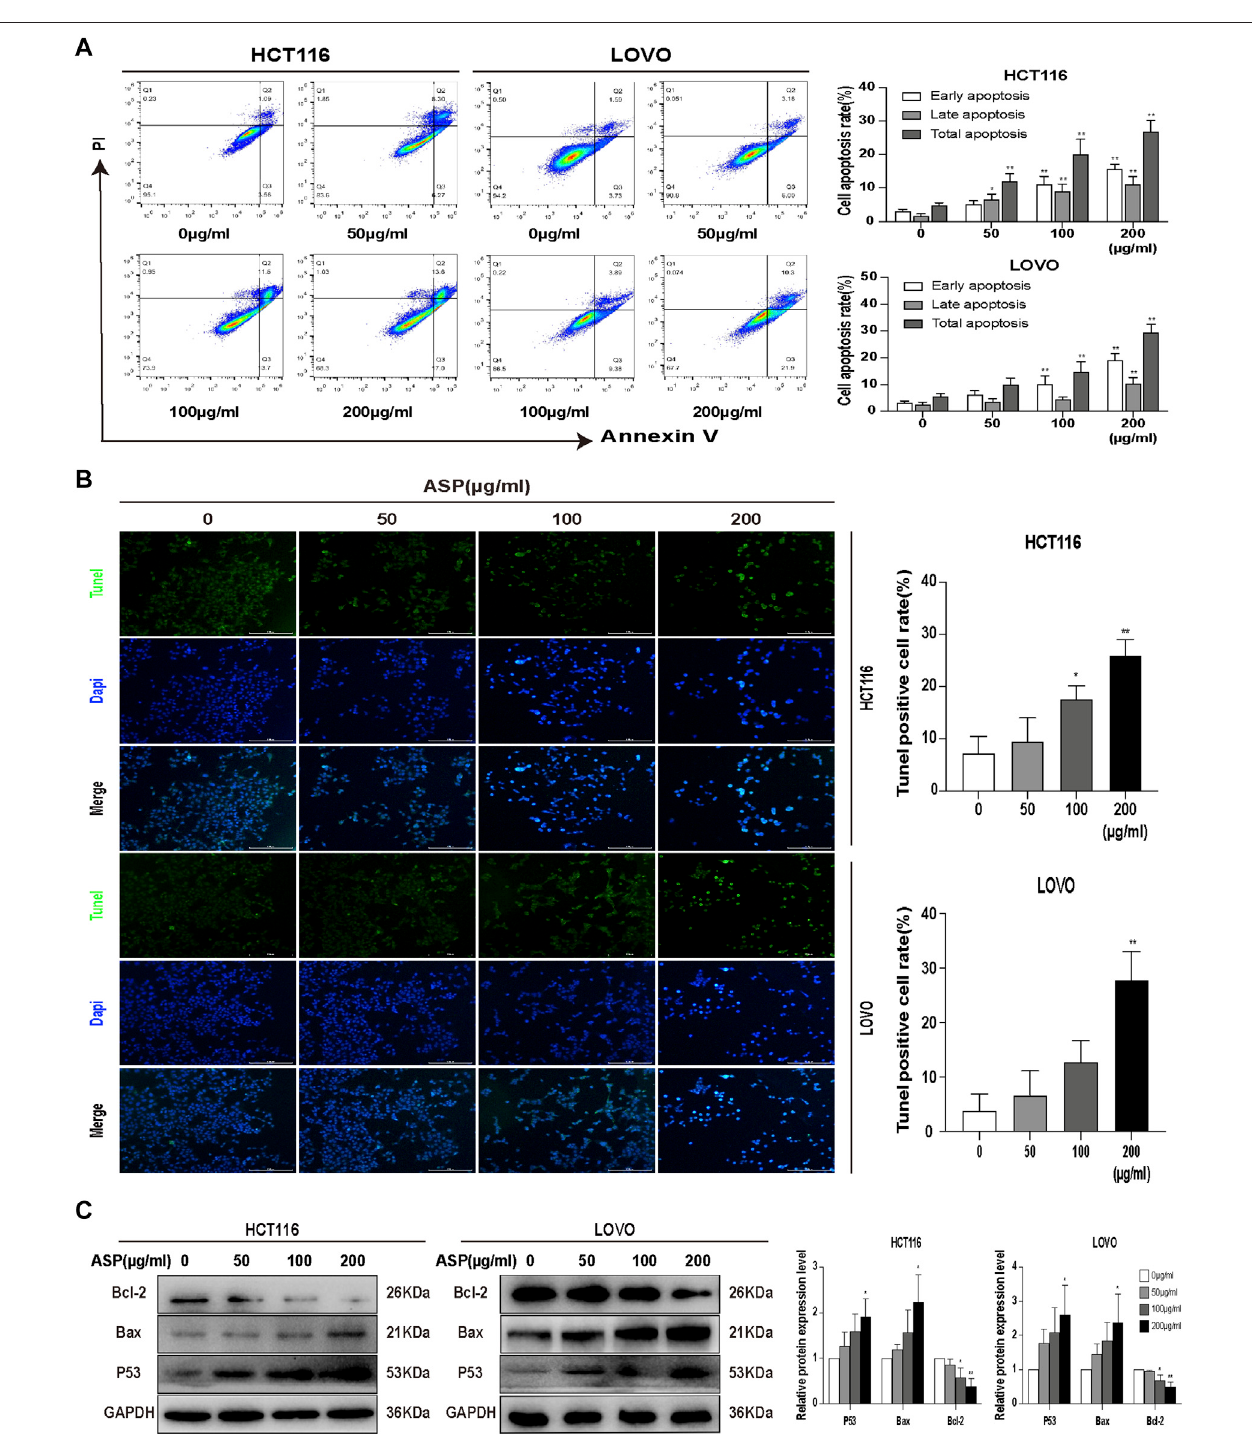
FIGURE7| Asparagus aqueous extract (ASP) signi fi cantlypromotedapoptosis in colorectal cancercells. (A) Flow cytometry analysisshowedthat ASPpromoted early and late apoptosis in HCT116 and LOVO cells (n = 3 in each group). (B) TUNEL staining analysis showed that ASP promoted apoptosis (×200). (C) Expression of Bcl-2 decreased and expression of TP53 and Bax increased with increasing ASP concentration ( n = 3 per group) Values are shown as the mean ± SD, * p < 0.05, ** p < 0.01 vs . the control.